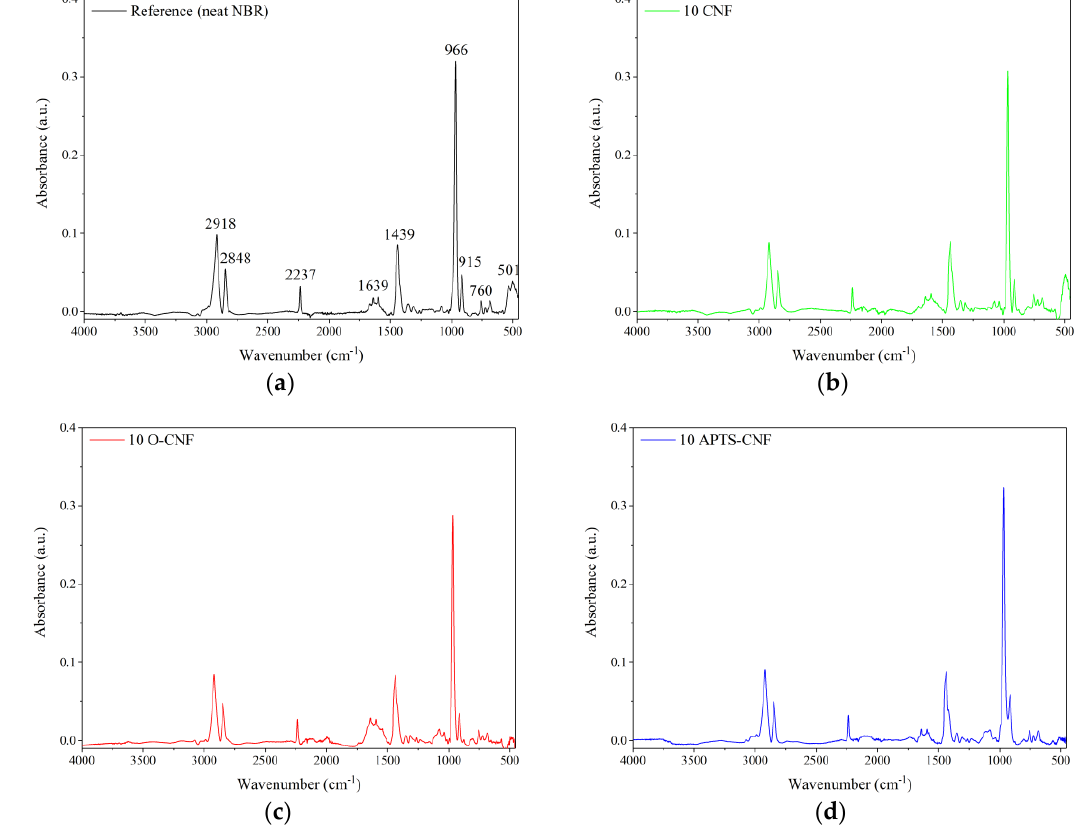
Figure 8. Fourier transform infrared spectroscopy (FTIR) spectra of the studied composites: ( a ) unfilled NBR, ( b ) NBR filled with 10 phr of CNF, ( c ) NBR filled with 10 phr of oxidized (O)-CNF, and ( d ) NBR filled with 10 phr of APTS-CNF.